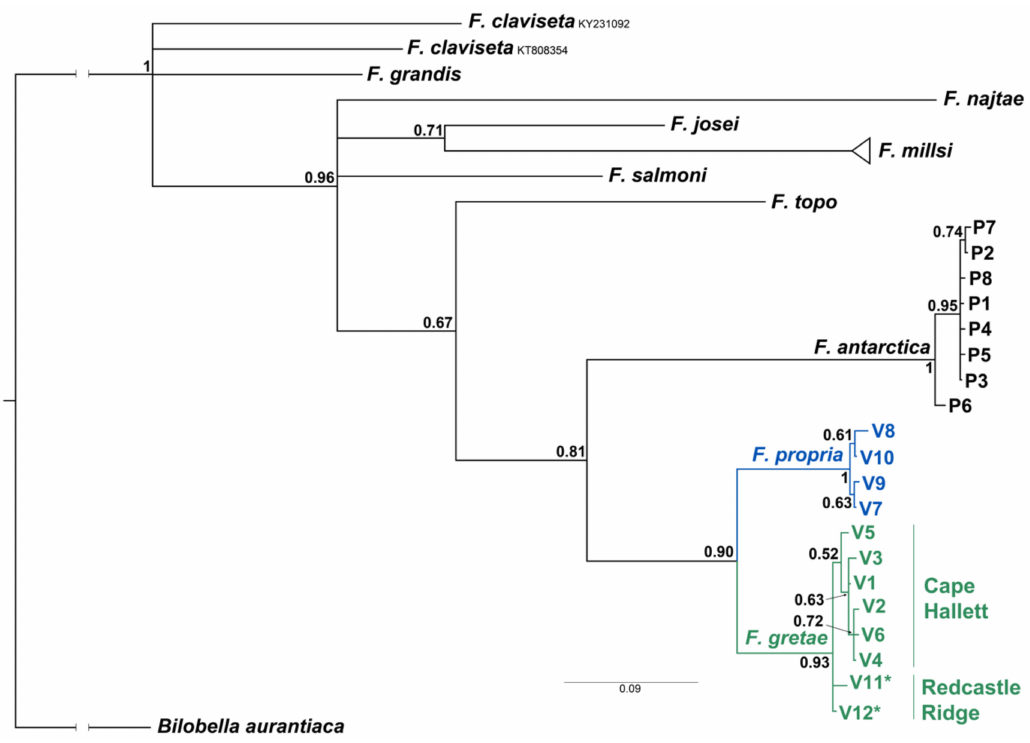
Figure 4. Phylogenetic tree of Friesea species based on cox1 sequences and inferred with Bayesian method. Numbers at nodes indicate values of posterior